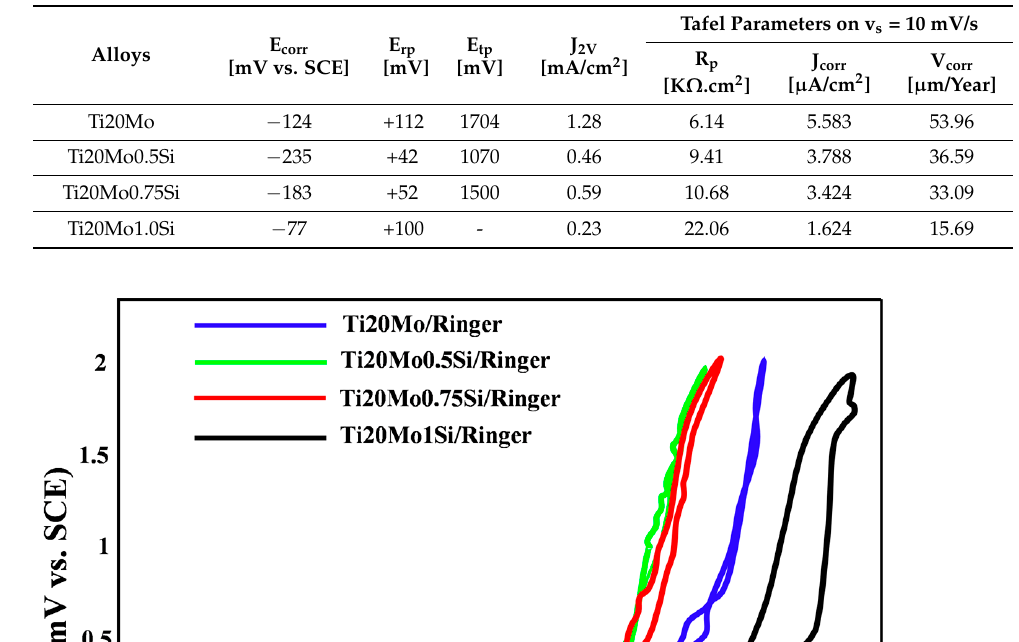
Table 4. Corrosion parameters obtained from cyclic polarization curves in Ringer’s solution.